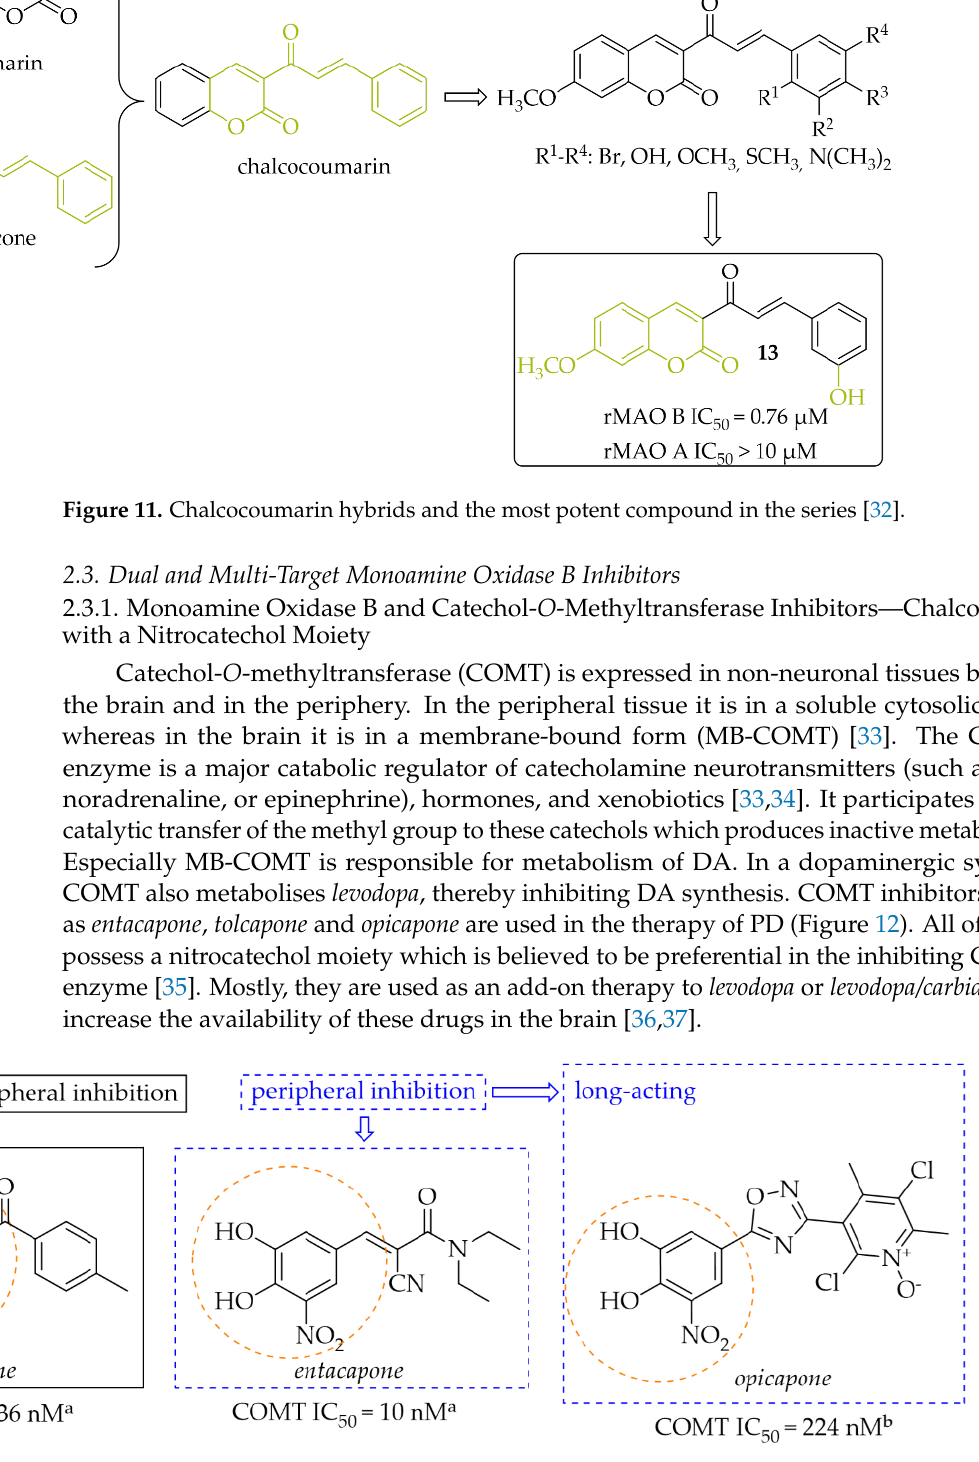
Figure 11. Chalcocoumarin hybrids and the most potent compound in the series [32].